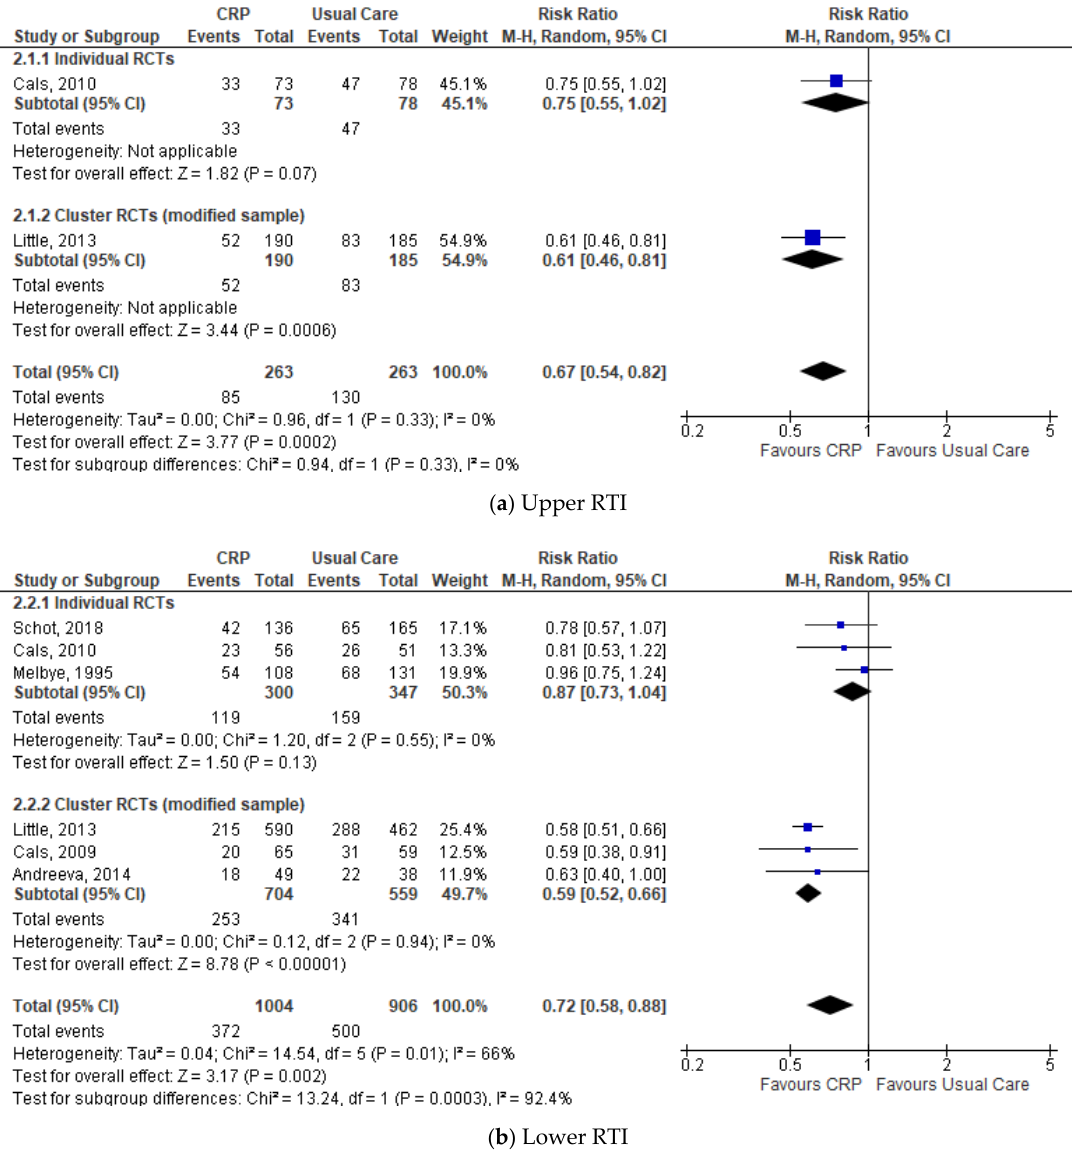
Figure 3. Comparison: CRP-POCT versus usual care. Antibiotic prescribing at index consultations by type of RTI: ( a ) Upper RTI; ( b ) Lower RTI. CRP, C-Reactive Protein Point Of Care Test; RCTs, Randomised Controlled Trials; M-H, Mantel-Haenszel; CI, Confidence Interval; df, degrees of freedom; I 2 , heterogeneity between trials.